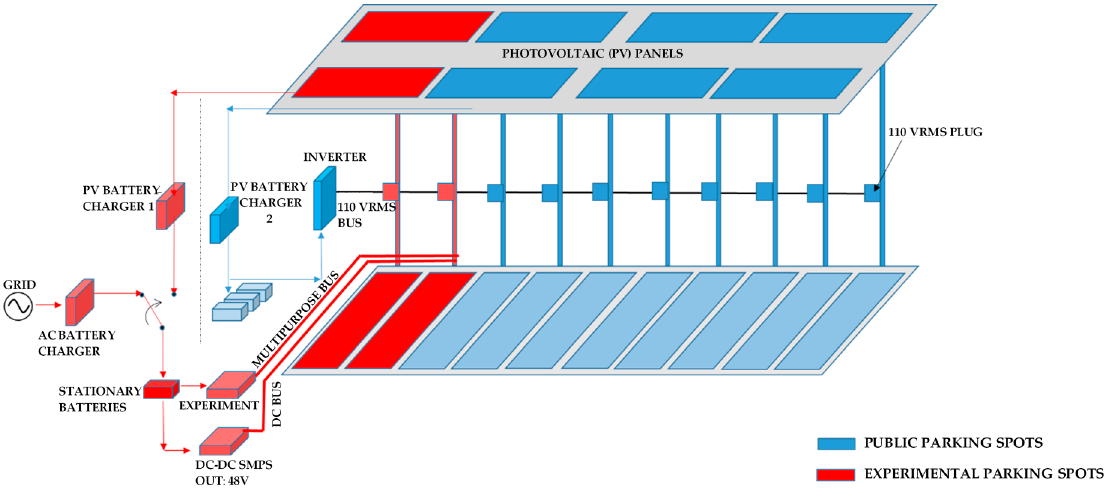
Figure 10. BiCiSOLAR charging station at Sergio Arboleda University.